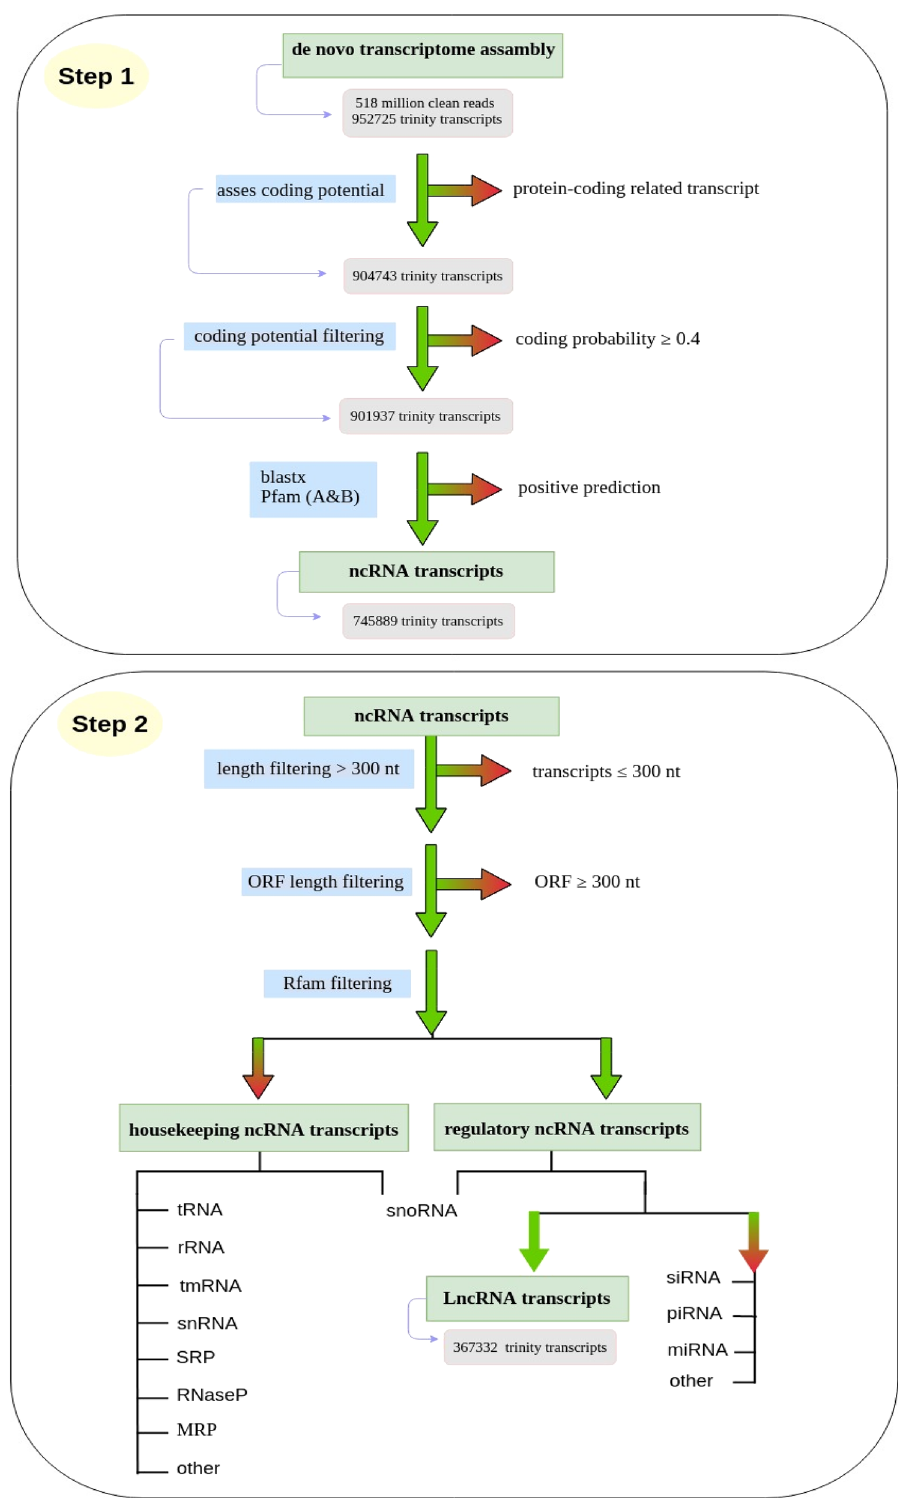
Figure 1. Overview of experimental and computational filtering pipeline (ECF). ECF pipeline is composed of computational and experimental steps: (1) Identification of ncRNAs, (2) Annotation and classification of ncRNAs, (3) Prediction of high reliable lncRNAs. Briefly, the cleaned reads were assembled using Trinity and then evaluated for protein coding portability with coding potential calculator 2 (CPC2). A series of protein annotations were performed using BLASTX and Pfam. The remaining ncRNA transcripts were filtered based on coding probability ≥ 0.4, transcript length ≤ 300 nt and, open reading frames (ORFs) ≥ 300nt. INFERNAL and RNACentral were used to classify ncRNAs into various ncRNA families. The housekeeping ncRNAs also were removed. Transcripts that passed all criteria steps of ECF pipeline were classified as lncRNAs. In addition, RNACentral and NONCOD databases were used to predict the known lncRNAs. Finally, transcripts remaining after application of various filtering steps based on FPKM < 1 and PLEK, were known as novel set of high confidence